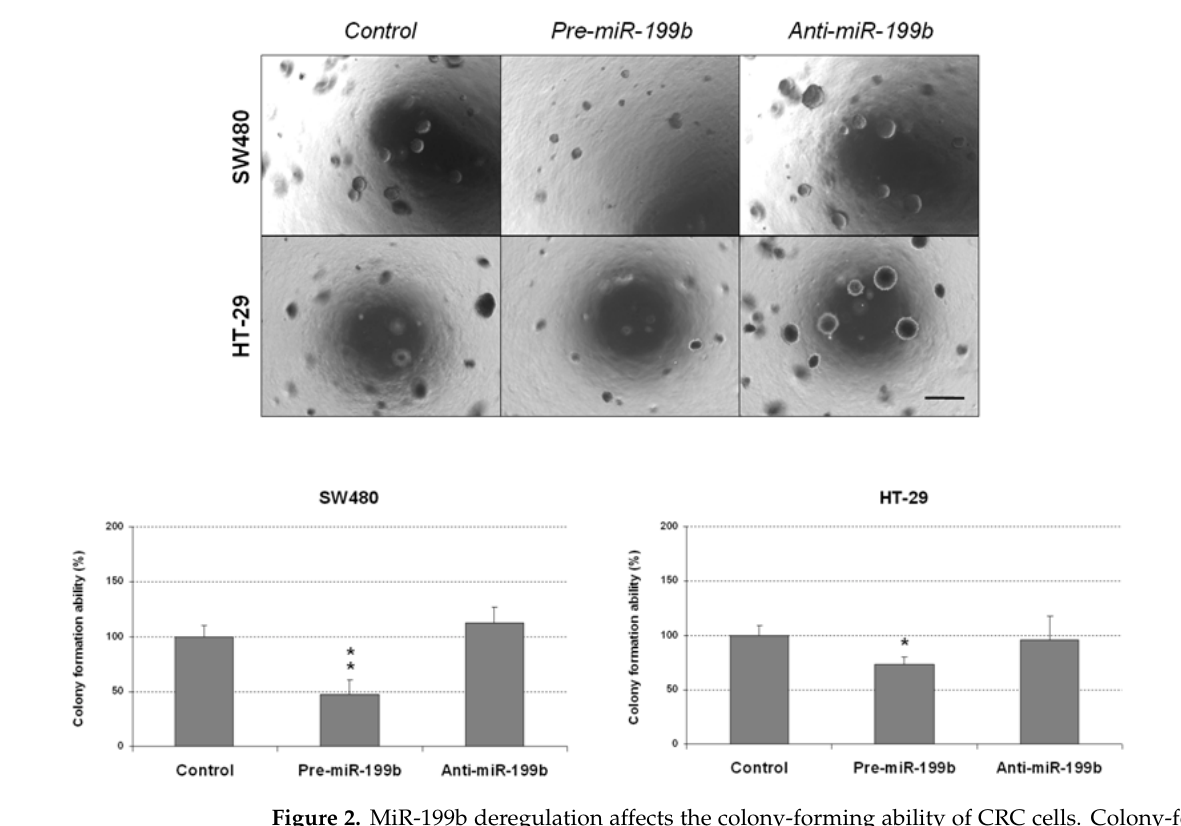
Figure 2. MiR-199b deregulation affects the colony-forming ability of CRC cells. Colony-forming assays showing the effect on the anchorage-independent cell growth of SW480 and HT-29 cell lines after ectopic miR-199b silencing or overexpression; * p < 0.05; ** p < 0.01. Scale bar: 200 µm.